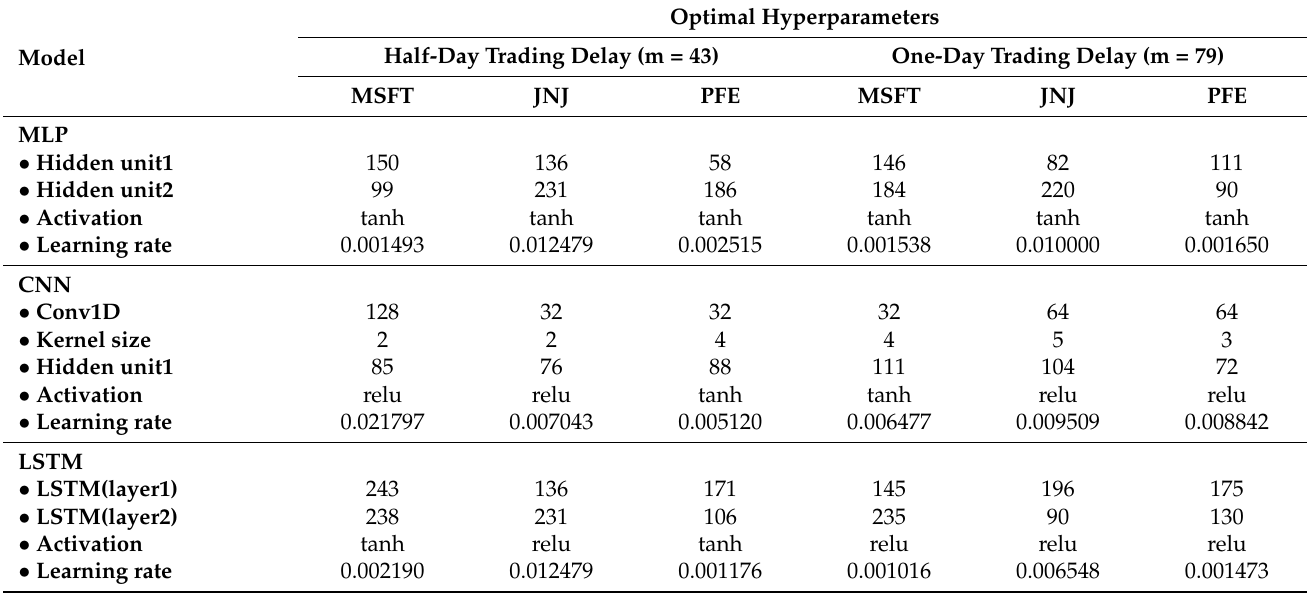
Table 3. The optimal hyperparameters of three deep learning